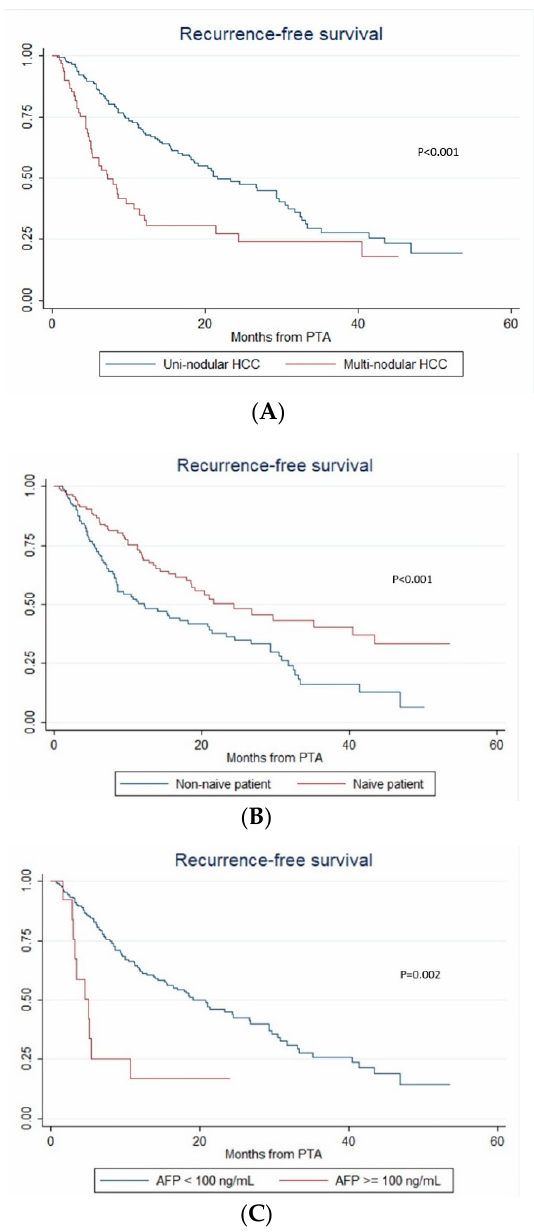
Figure 4. In patients with uninodular vs. multinodular HCC ( A ), in treatment naïve vs. non-treatment naïve patients ( B ), and in patients with AFP < 100 ng/mL vs. AFP ≥ 100 ng/mL ( C ) (Kaplan–Meier analyses).